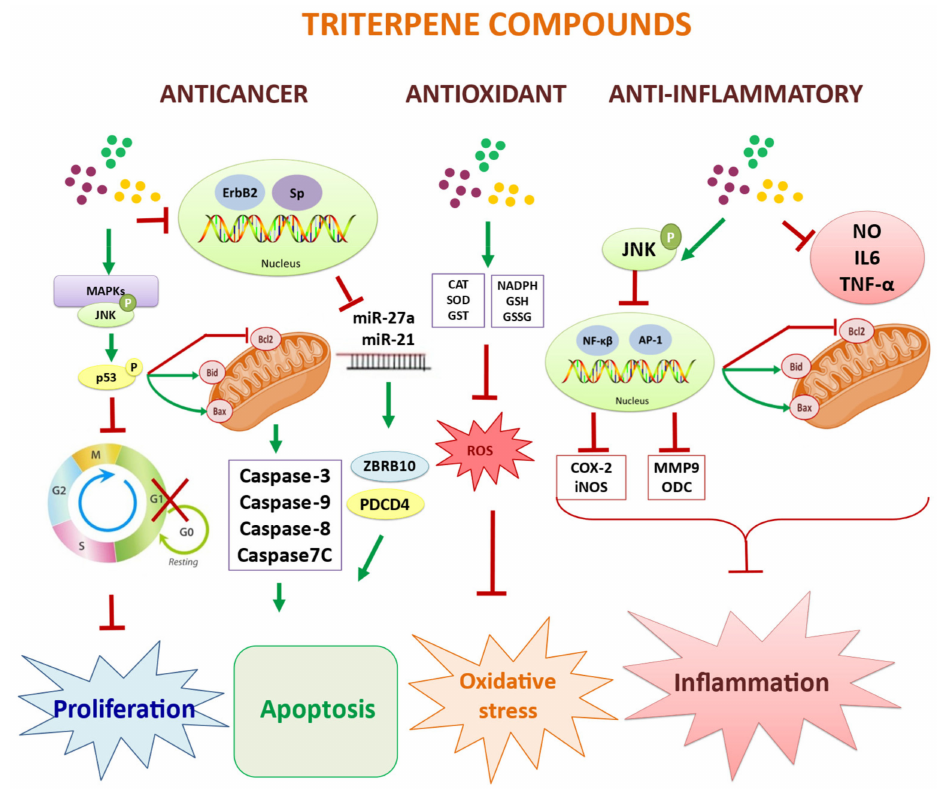
Figure 5. Schematic representation of the main molecular mechanisms involved in the action of the most important bioactivities related to the role of the triterpenoids present in the fruit and leaf of the olive